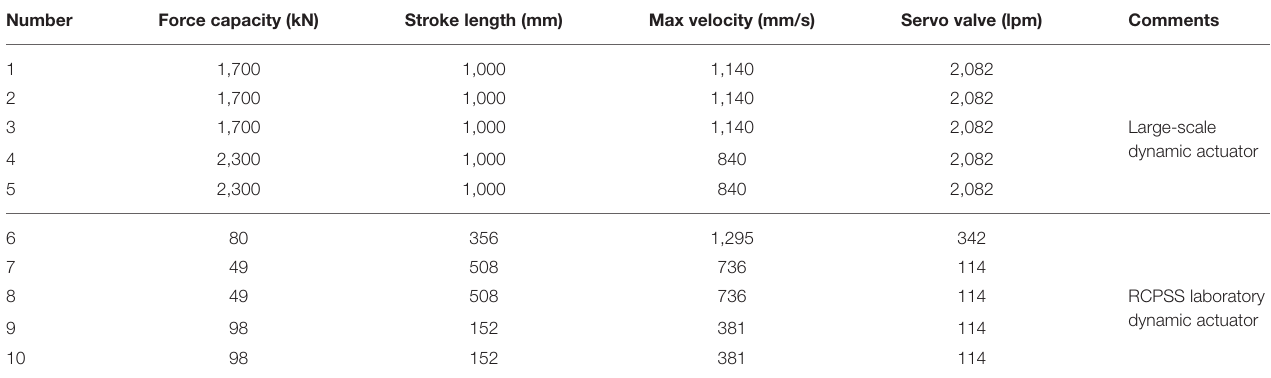
TABLE 1 | Dynamic actuator